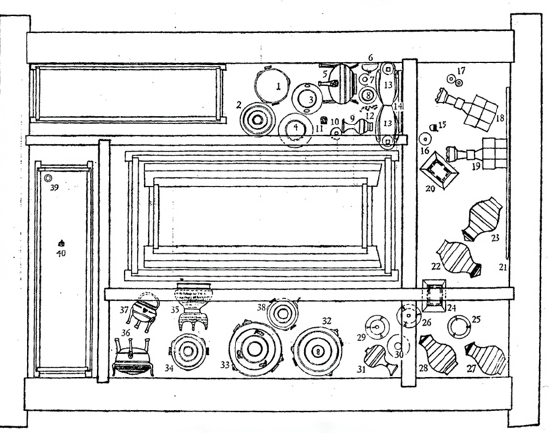
Figure 9. Line drawing of Tomb 5 at Baizifan showing two sculptures in the head compartment of the tomb. From Hubei sheng Echeng xian bowuguan (1983, p. 226, fig. 4). Three sculptures dated slightly later than the Baizifan sculptures from the late fourth Huanggang County are quite unusual in comparison to the Hanxi models and reflect more tenuous cultural ties with the Chu heartland. 32 The head compartment of Tomb 1 at